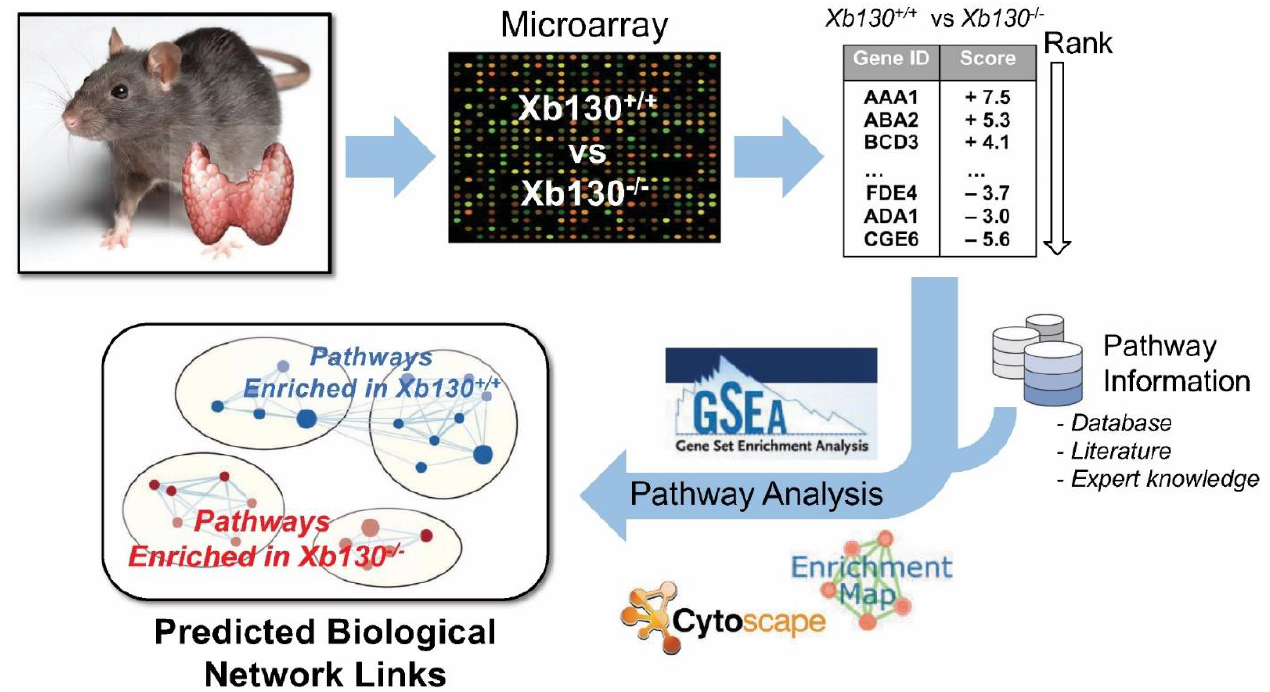
Figure 1. Transcriptomic profiling of gene expression in the thyroid glands of Xb130 −/− mice and their littermates. Gene set enrichment analysis is the major method that compares gene sets between the two different groups.